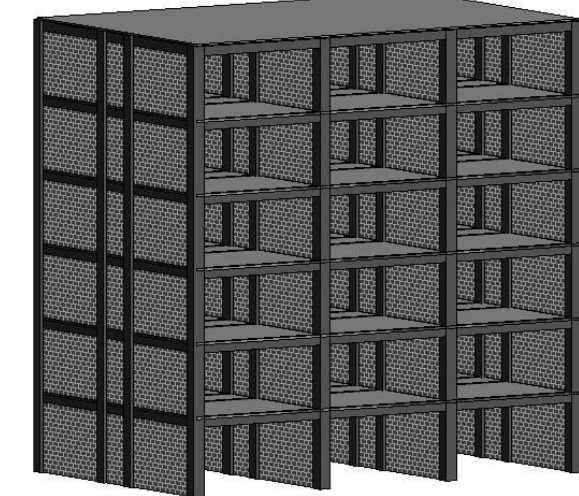
Figure 2. The arrangement of beams. Since infill walls are always arranged irregularly along the height of the building to accomplish different functions, six models with different infill wall arrangements were Table 1. Sizes and reinforcement details of frame columns. analyzed, as described in Figure 3. Model M1 is the bare frame. Model M2 is the frame with infill walls on all the storeys. Model M3 is the frame without infill walls on the first two storeys. Model M4 is the frame without infill walls on the third and fourth storeys. Model M5 is the frame without infill walls on the top two storeys. Model M6 is the frame without infill walls in the middle bay.